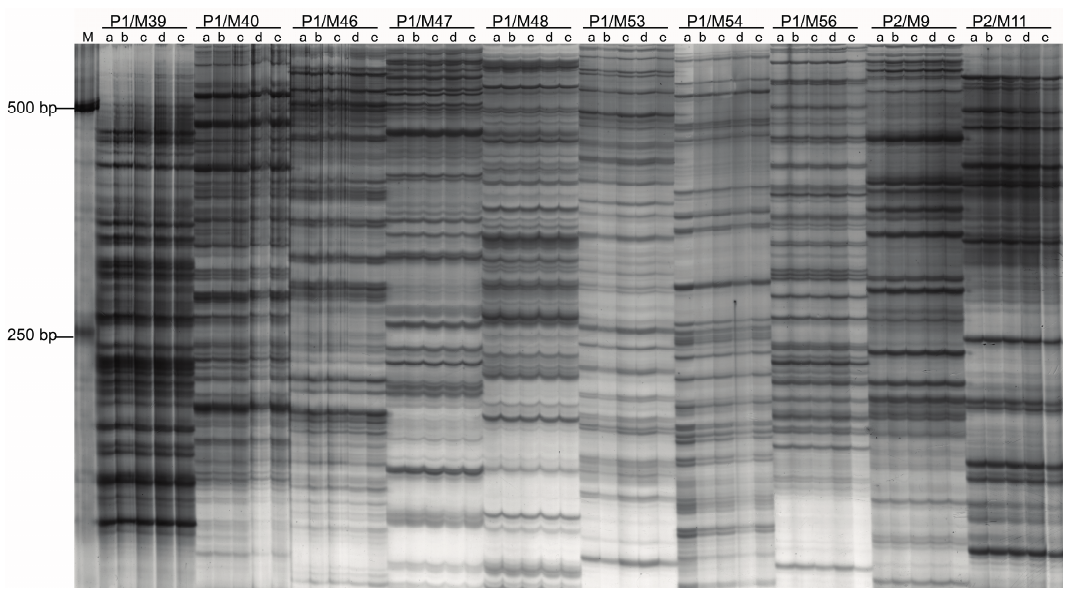
Figure 3. Amplified fragment length polymorphism (AFLP) amplification of MMS-treated PaWB plantlets. a : PaWB plantlets; b : 15 mg·L − 1 MMS; c : 30 mg·L − 1 MMS; d : 45 mg·L − 1 MMS; e : HP; M : DNA Marker. P1/M39–P2/Mx: primer